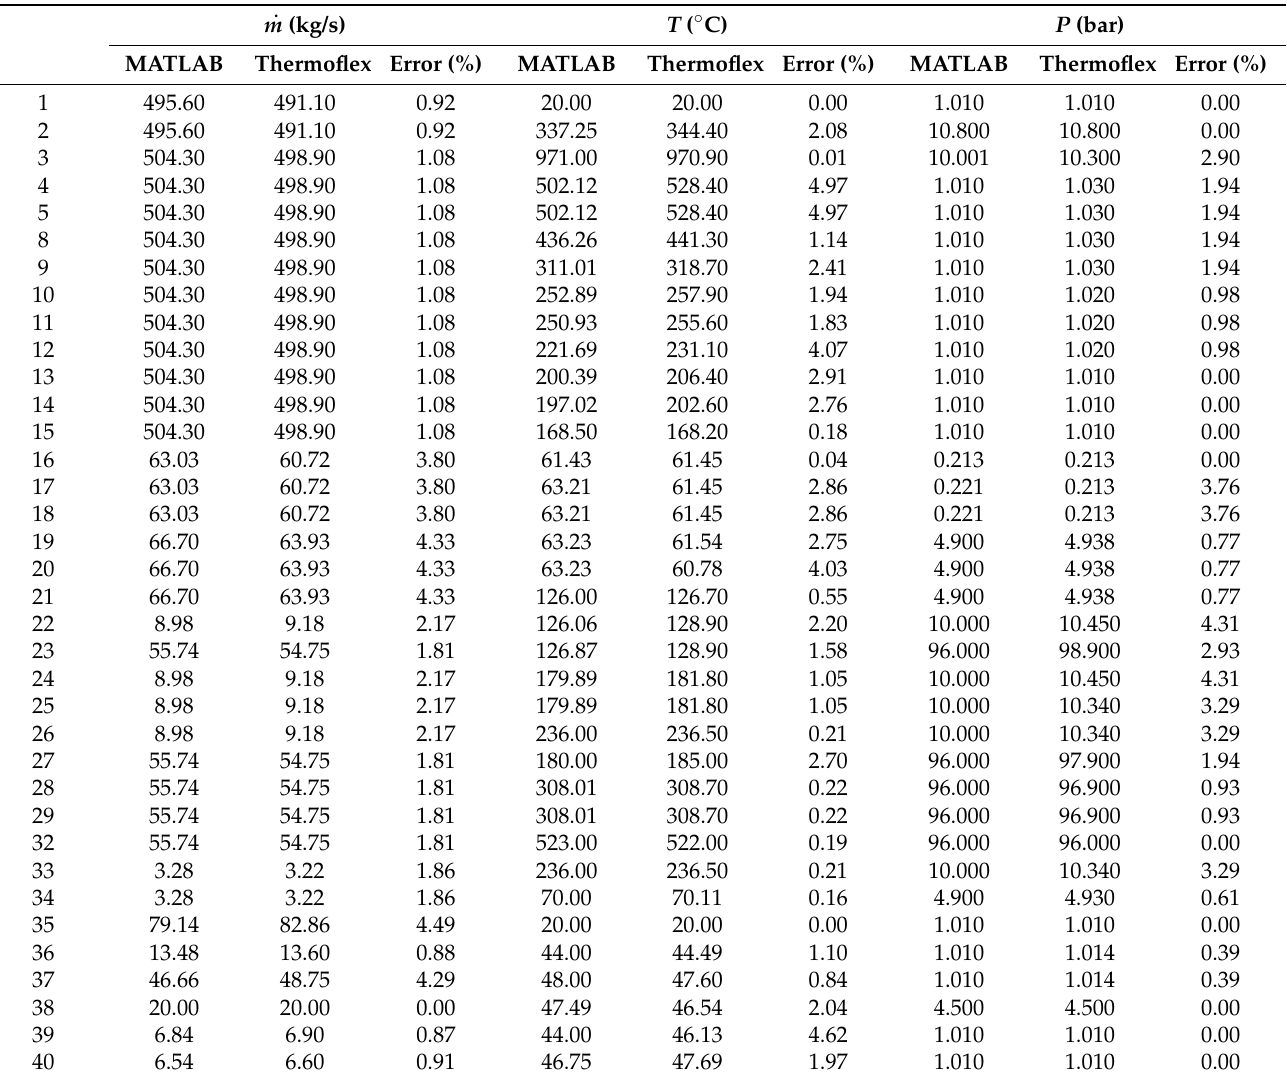
Table A4. Verification of thermodynamic simulation results of the different process streams. . m